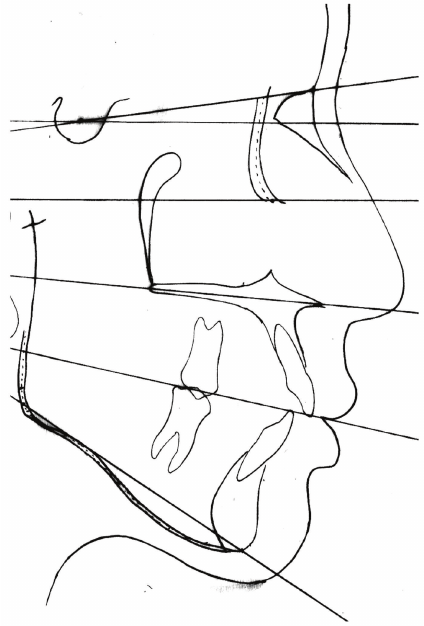
Figure 4: Pretreatment cephalometric tracing.